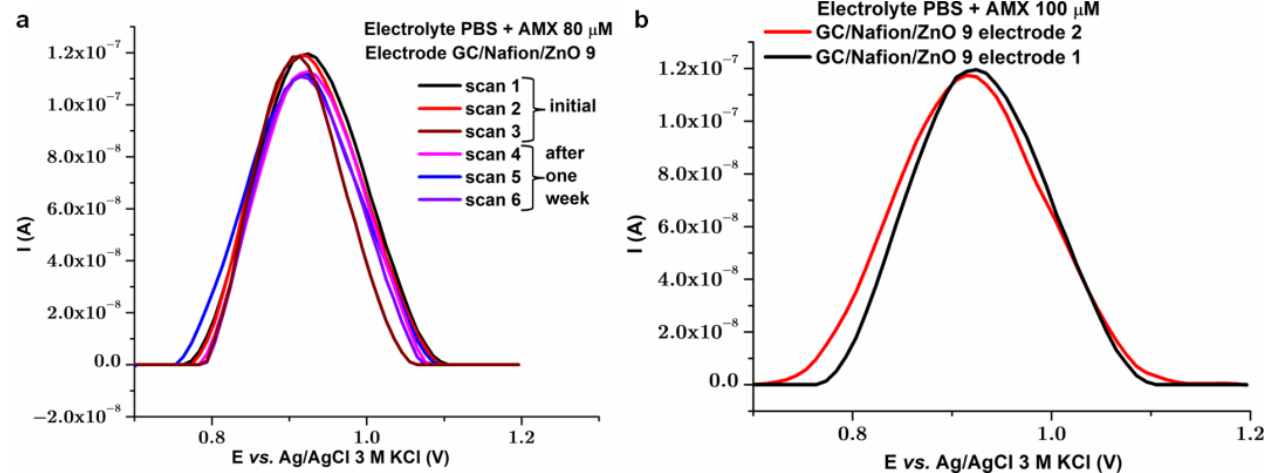
Figure 7. DPV curves in PBS solution + AMX 100 μM corresponding to GC/Nafion/ZnO 9 and GC/Nafion/ZnO 6.